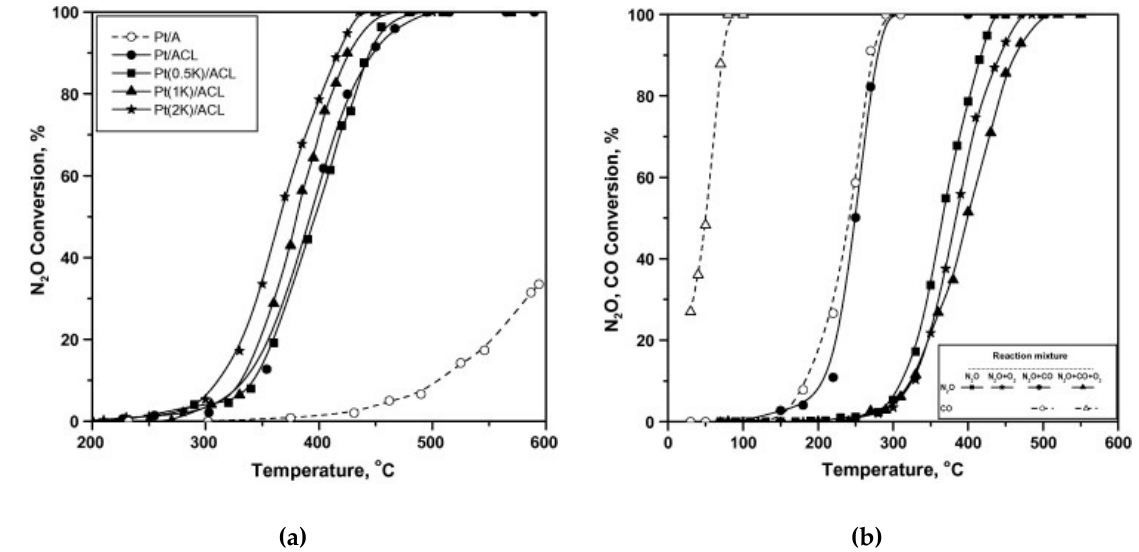
Figure 14. ( a ): N 2 O conversion profiles as a function of temperature (light-off curves) for bare Pt/ γ - Al 2 O 3 , structurally promoted Pt/ACL and doubly-promoted Pt(K)/ACL catalysts under